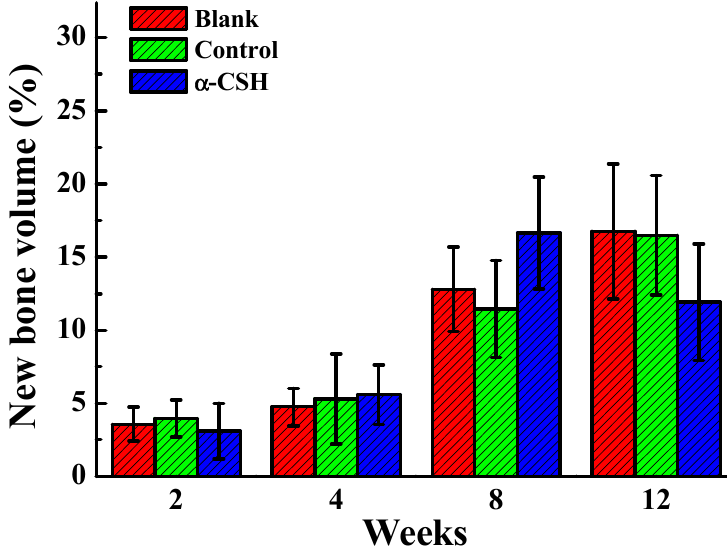
Figure 4. Bone volume percentage in artificially-created defects from µ -CT evaluation at 2, 4, 8, and 12 weeks after treatment. ( p > 0.05).